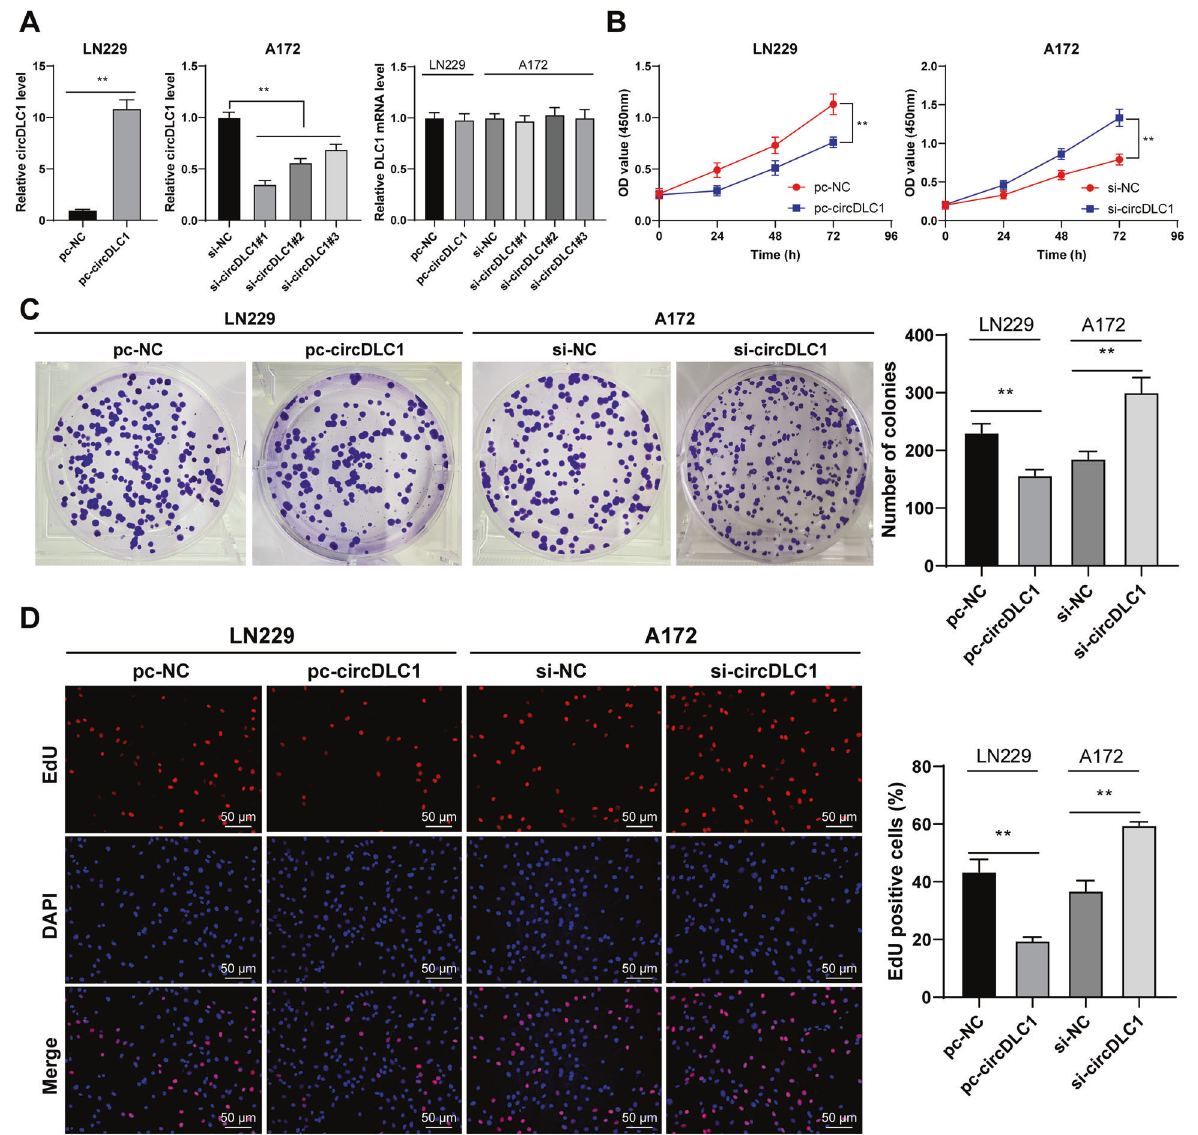
Fig. 2 circDLC1 overexpression suppressed glioma cell proliferation. circDLC1 pcDNA 3.1 (pc-circDLC1) was transfected into LN229 cells, with NC pcDNA 3.1 (pc-NC) as control; circDLC1 siRNA (si-circDLC1) was transfected into A172 cells, with NC siRNA (si-NC) as control. A circDLC1 and linear DLC1 expressions were detected using RT-qPCR. B – D Cell proliferation was measured using CCK-8 assay ( B ), colony formation assay ( C ), and EdU staining ( D ). The cell experiment was repeated three times independently. Data are presented as mean ± standard deviation. The comparisons between two groups in panels A /C, D were analyzed using t -test. The comparisons among multiple groups in panel A were analyzed using one-way ANOVA, and the comparisons among multiple groups in panel B were analyzed using two- way ANOVA, followed by Tukey ’ s multiple comparisons test, ** p < circDLC1 on miR-671-5p expression; the transcriptional level (Fig. 5A), suggesting that circDLC1 may bind to miRNA [18]. The trend of CTNNBIP1 was opposite to that of miR-671-5p (p < 0.01, downstream miRNAs of circDLC1 were predicted (Supplementary Fig. 5F, G). Then, we intervened in miR-671-5p expression (p < Table 2 and Fig. 5B), in which miR-671-5p is highly expressed in 0.01, Fig. 5H) and found that miR-671-5p overexpression glioma [19, 20]. The target genes of miR-671-5p were predicted decreased the CTNNBIP1 transcriptional level in the combined and intersected (Fig. 5B), in which CTNNBIP1 is poorly expressed treatment group, while miR-671-5p silencing increased the in glioma [21, 22]. We identi fi ed the binding sites between CTNNBIP1 transcriptional level ( p < 0.01, Fig. 5I). Finally, we circDLC1 and miR-671-5p, and miR-671-5p and CTNNBIP1 found that miR-671-5p expression was elevated and CTNNBIP1 through the database (Fig. 5C). Dual-luciferase and RNA pull- expression was reduced in glioma tissues and cells ( p < 0.05, down assays con fi rmed the binding relationships between Fig. 5J – L). miR-671-5p expression was negatively correlated with circDLC1 and miR-671-5p, and miR-671-5p and CTNNBIP1 ( p < circDLC1 and CTNNBIP1 expression in glioma tissues, and 0.01, Fig. 5D, E). circDLC1 overexpression alone decreased miR- CTNNBIP1 expression was positively correlated with circDLC1 671-5p expression and circDLC1 silencing alone increased miR- expression ( p < 0.05, Fig. 5M). Brie fl y, circDLC1 promoted 671-5p expression, while METTL3 silencing or METTL3 over- CTNNBIP1 transcription by competitively binding to miR-671-5p. expression reduced the regulatory effect of intervention of